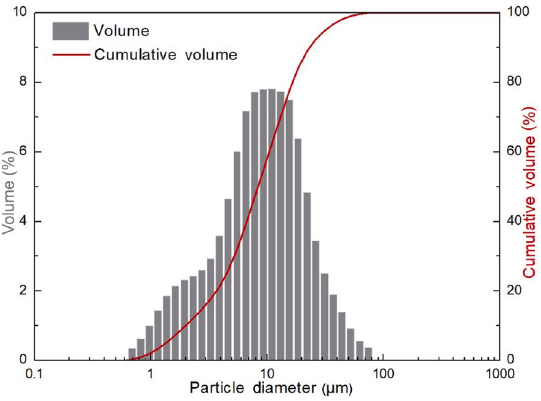
Fig. 2 Particle size distribution of Ti 3 AlC 2 powders after